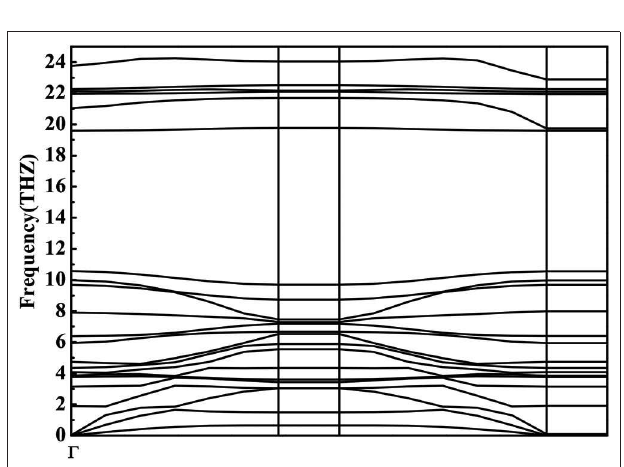
FIGURE 8 | Phonon dispersion for C-Ge codoped GaN